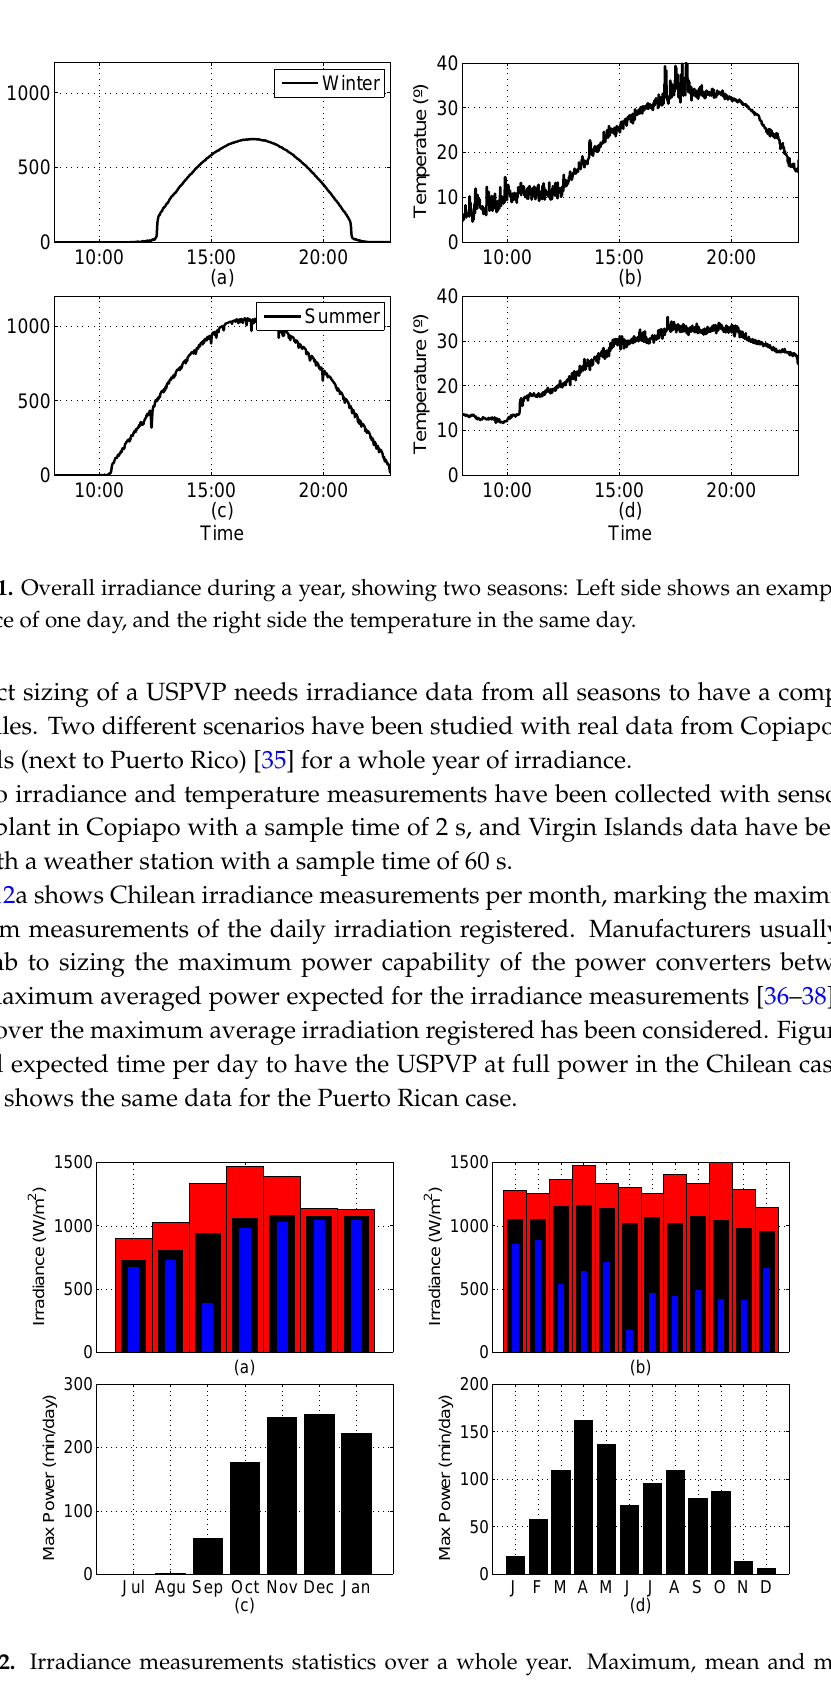
Figure 12. Irradiance measurements statistics over a whole year. Maximum, mean and minimum of maximum daily irradiation in red, black, and blue respectively, for ( a ) Chile; and ( b ) Puerto Rico. Expected minutes per day of the plant at full power for ( c ) Chile; and ( d ) Puerto